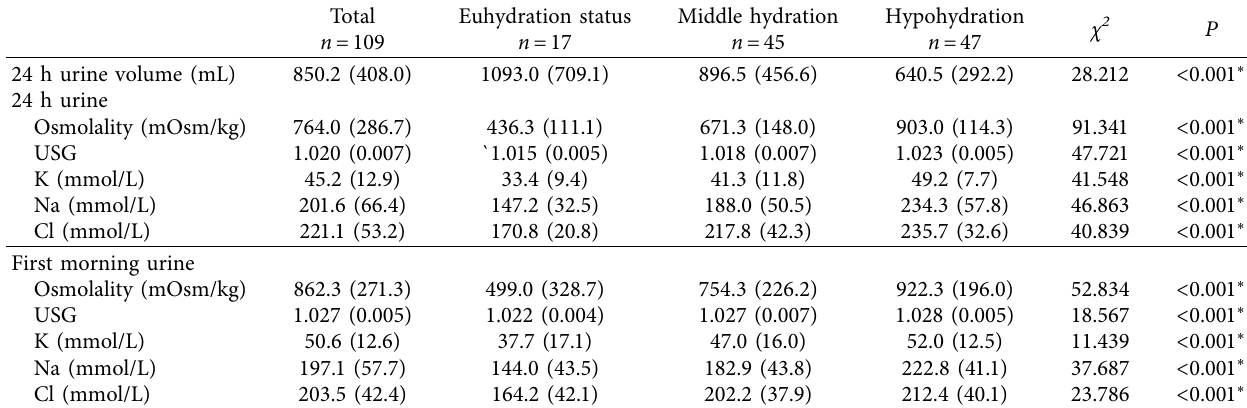
Table 4: Urine biomarkers of participants with different hydration statuses.